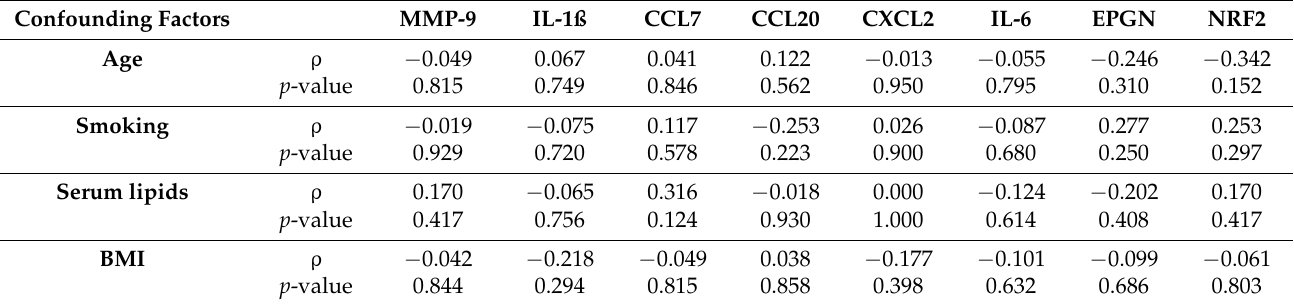
Table 2. Confounding factors.